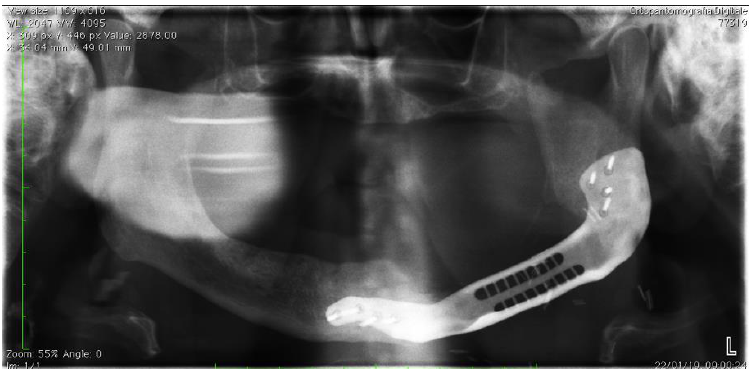
Figure 5. Postoperative orthopantomography in a patient treated for left-body biphosphonate-related osteonecrosis of the mandible (BRONJ) .